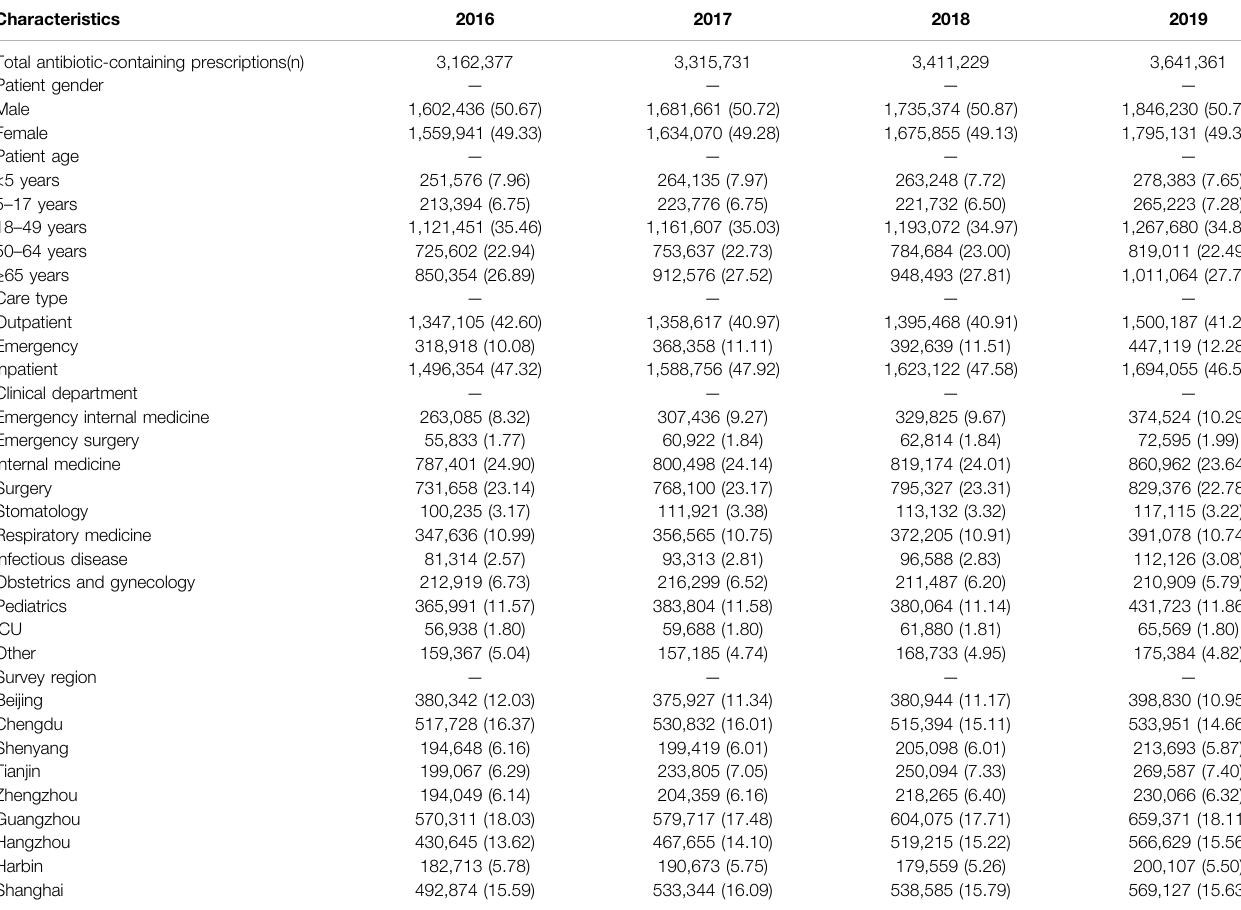
TABLE 1 | Patient-related associated with antibiotic prescribing in health-care institutions in nine cities, 2016 – 19.